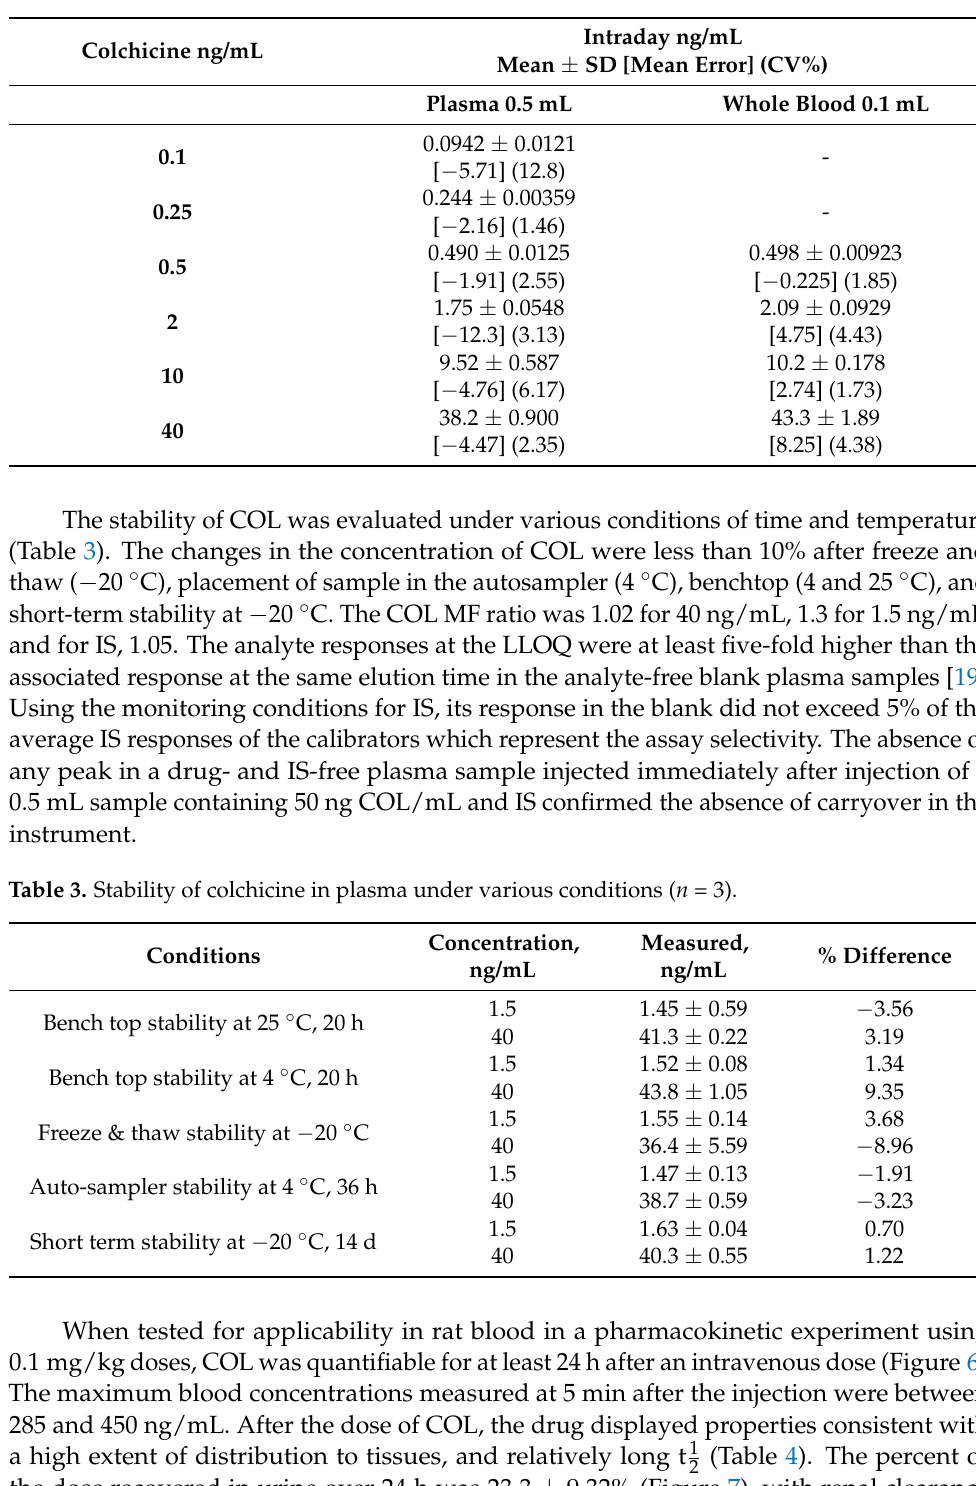
Table 2. One day validation of colchicine in 0.5 mL plasma and in 0.1 mL of whole blood.